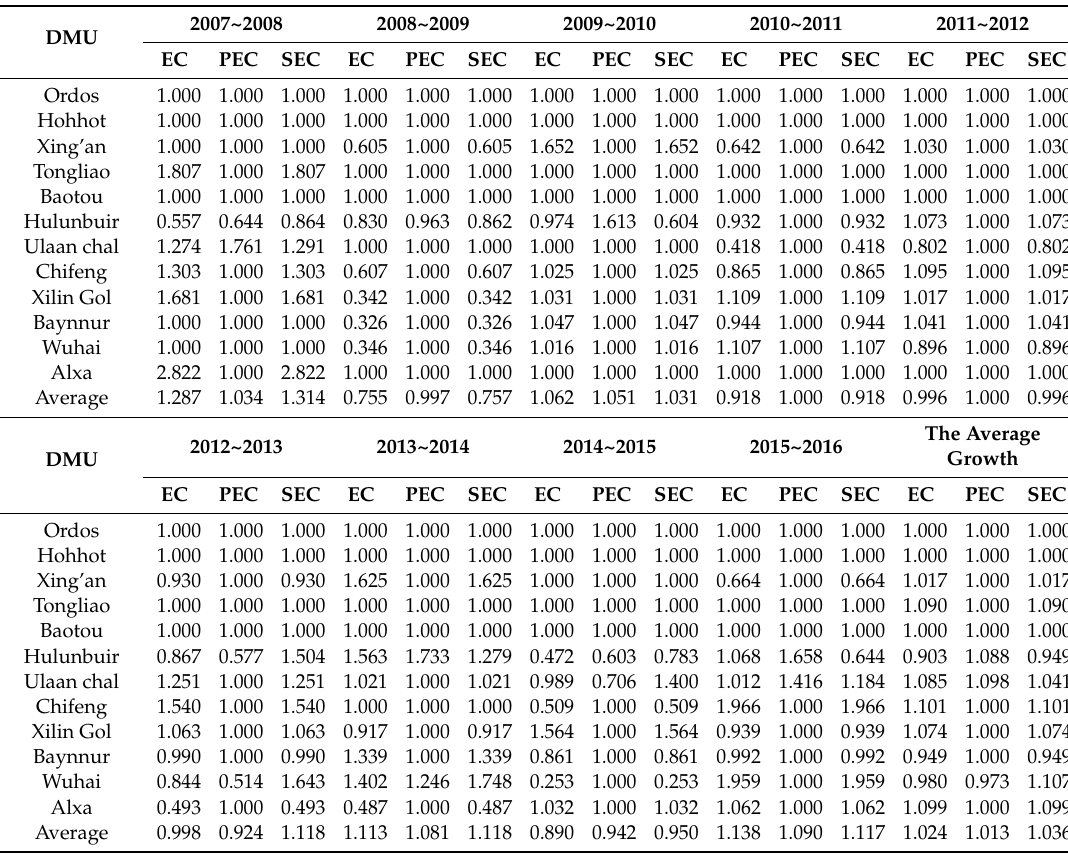
Table 5. The values of EC, pure technical e ffi ciency change (PEC) and scale e ffi ciency change (SEC) in Inner Mongolia cities from 2007 to